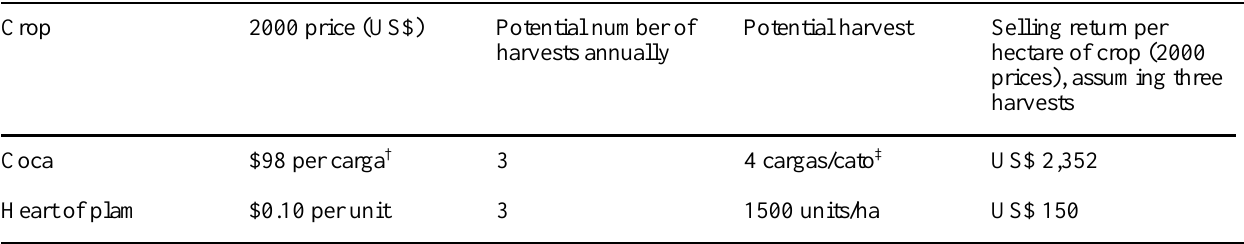
Table 6. Comparison of the economic returns from coca and heart of palm (source: interview data, 2000)